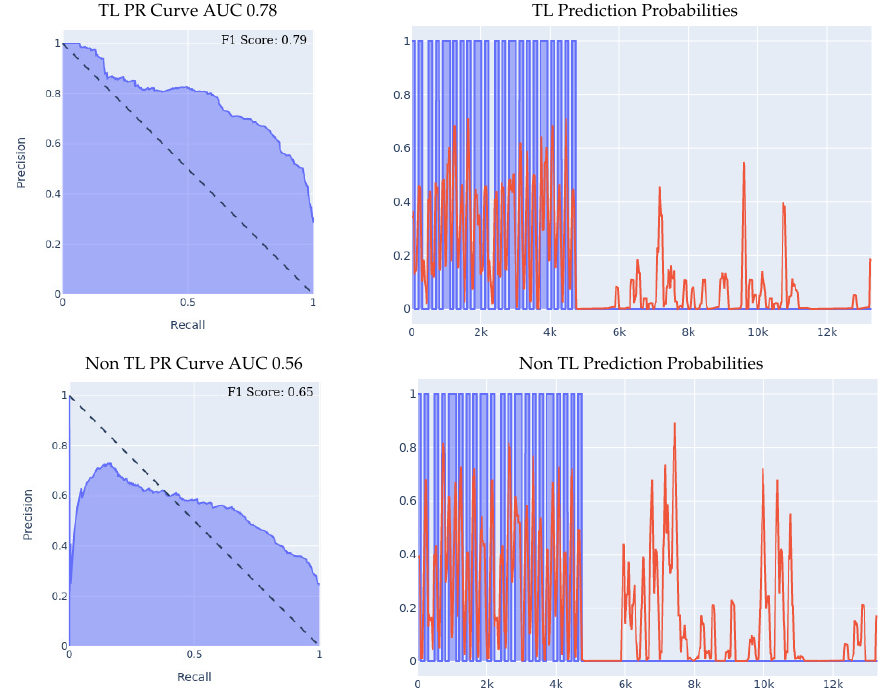
Figure 8. Leave-one-person-out data split experiment for MSBAND to meta-sensor. For prediction probabilities, the x axis is the time, the y axis is the prediction threshold, the blue data is the real labels, and the red data is the prediction probabilities. For the F1 Scores, the averaged F1 score of all 8 iterations of the cross-validation is shown in the top right corner of the PR